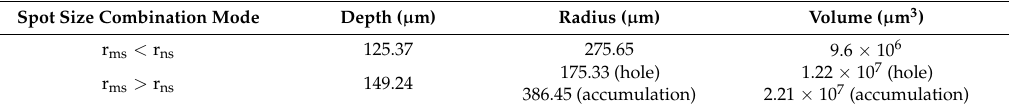
Table 2. Comparison of ablation morphology data of aluminum alloy.